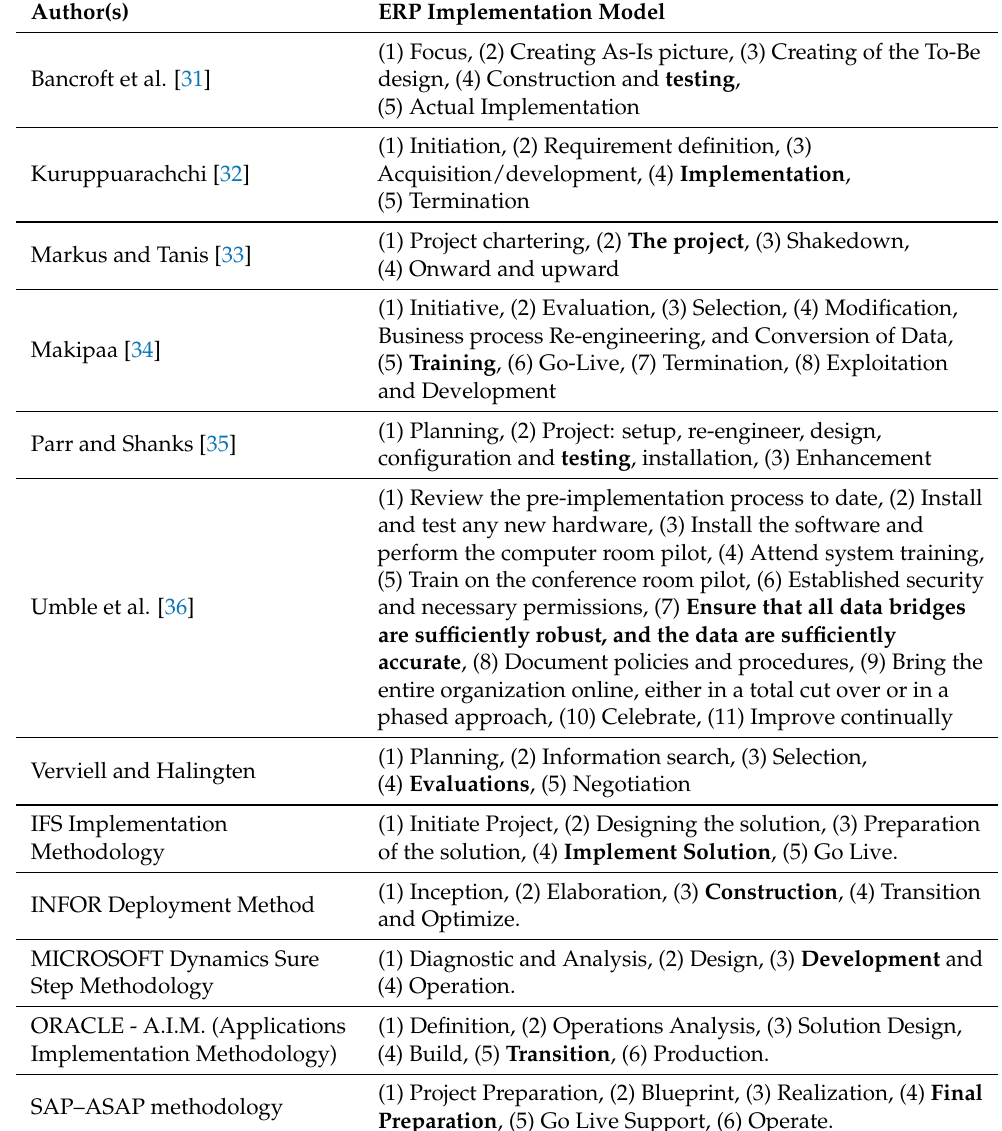
Table 1. ERP implementation methodologies both described in the literature and in the ERP leader vendors own methodology are suited to implement transactional but not analytical modules with migration of a small sample of data for business process testing